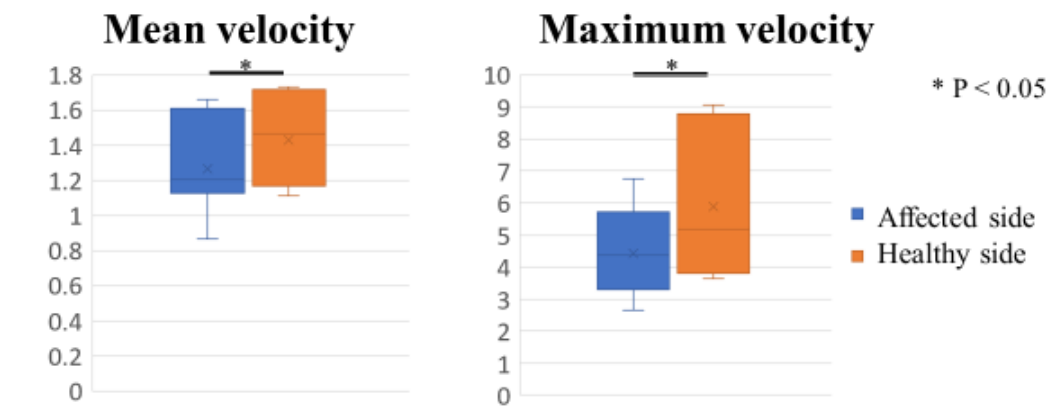
Figure 4. The mean velocity of CHL was significantly faster on the healthy side, and the maximum velocity was significantly faster on the healthy side.